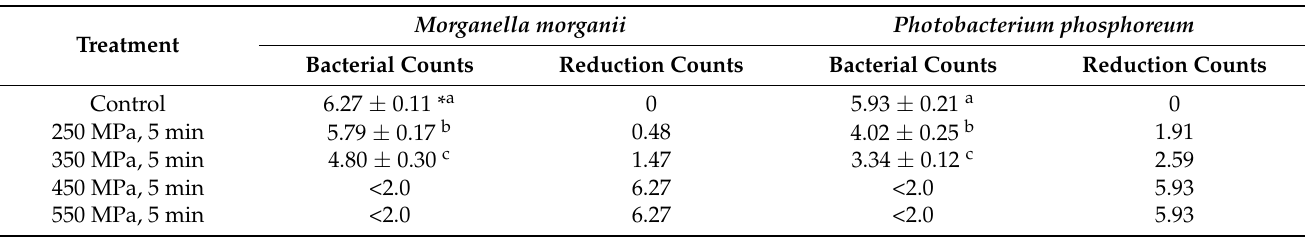
Table 1. Bacterial counts of tuna meat samples inoculated with Morganella morganii and Photobacterium phosphoreum after high-pressure processing treatment at 250, 350, 450, and 550 MPa for 5 min.